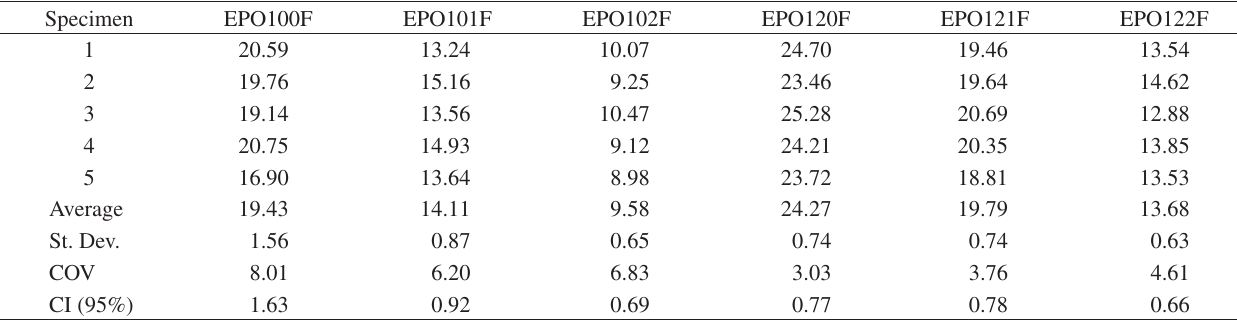
Figure 3. Some representative flexural strength vs. deflection curves of textile polymer concrete specimens. Table 2. Flexural strength test results of textile polymer concrete (MPa).